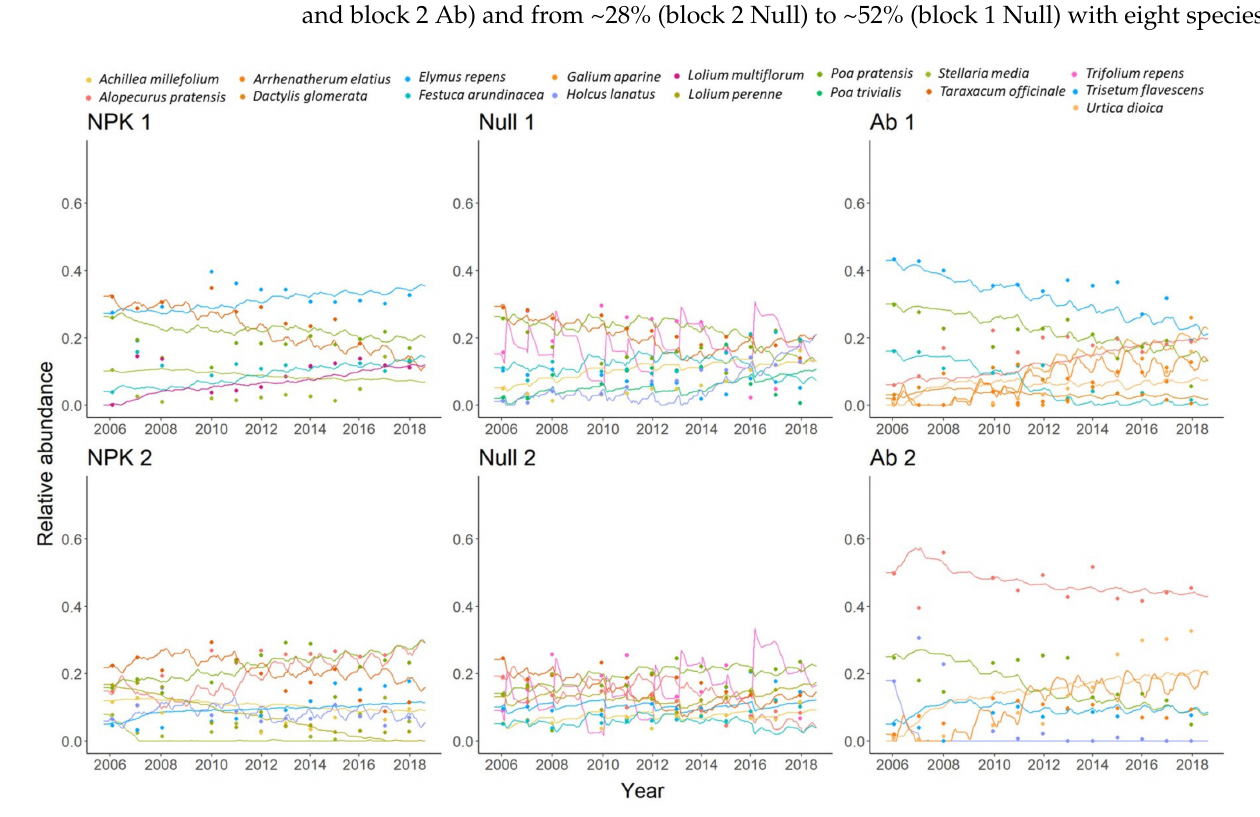
Figure 4. Observed (dots) and ModVege-CoSMo simulated (lines) fluctuations in the relative abun- dance of plant species in three treatments (NPK: fertilised; Null: unfertilised; Ab: abandoned) and two blocks (1, 2). Graphs of the individual plant species are in (Supplementary Material Figures